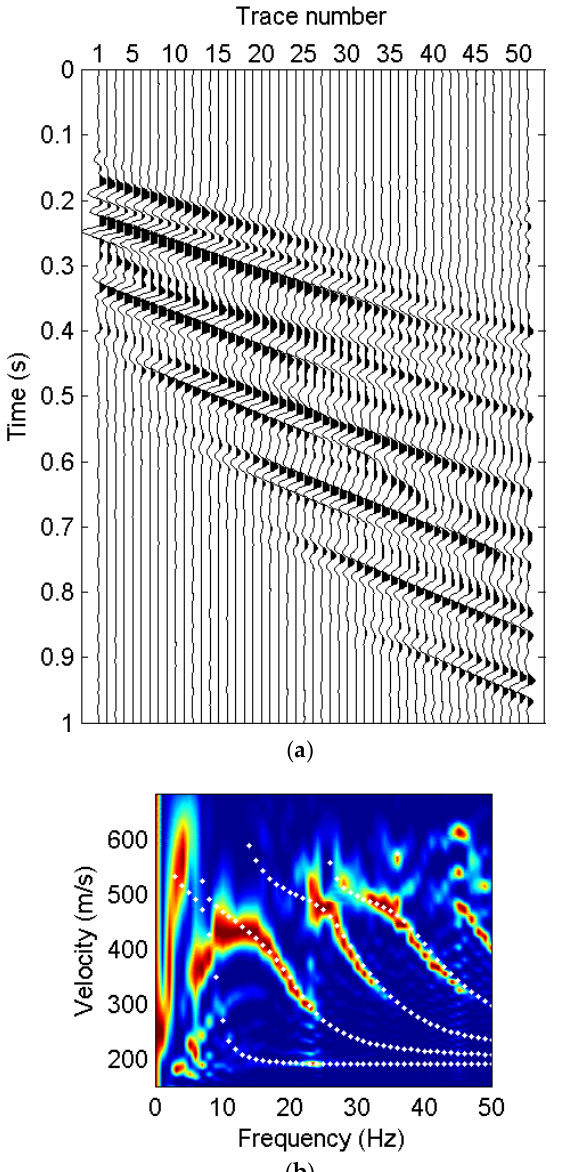
Figure 6. ( a ) The result of surface-wave extraction by the proposed method and ( b ) its image of dispersive energy in the f-v domain, where the white dotted lines represent the theoretical dispersion